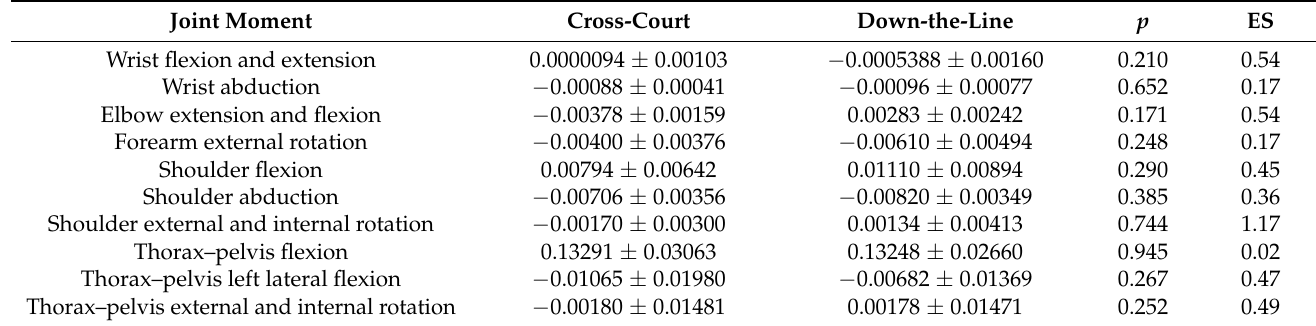
Table 5. The joint moment of upper body at the moment of lowest center of gravity ( n =